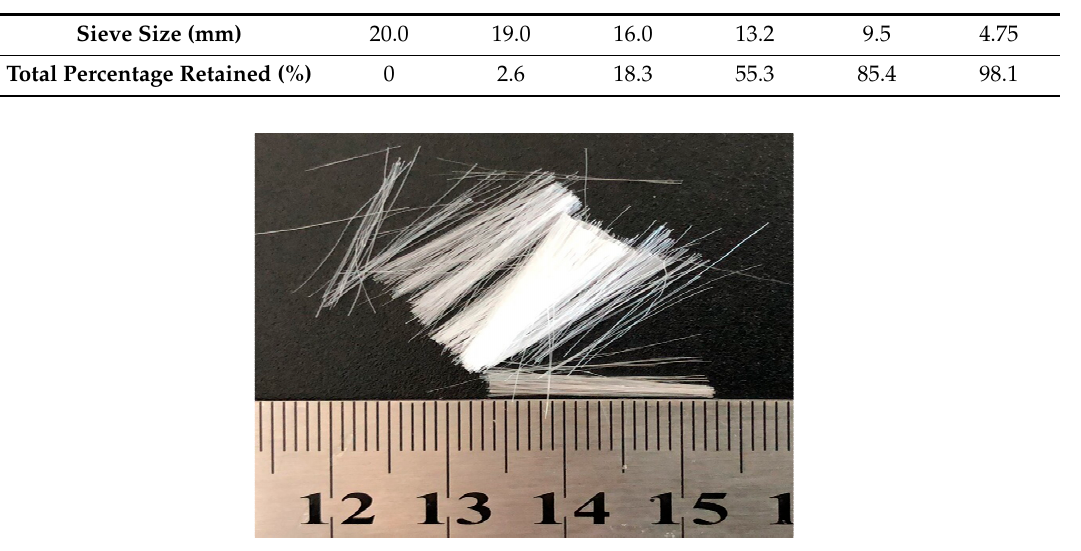
Figure 1. Photograph of PP fibre. Table 2. The gradation compositions of the fine aggregate.